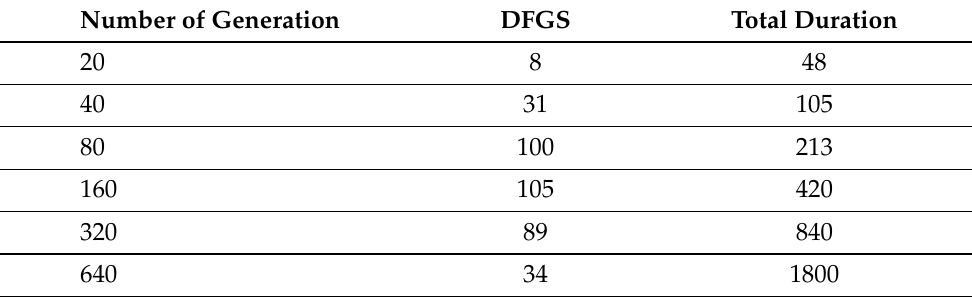
Table 3. Simulation